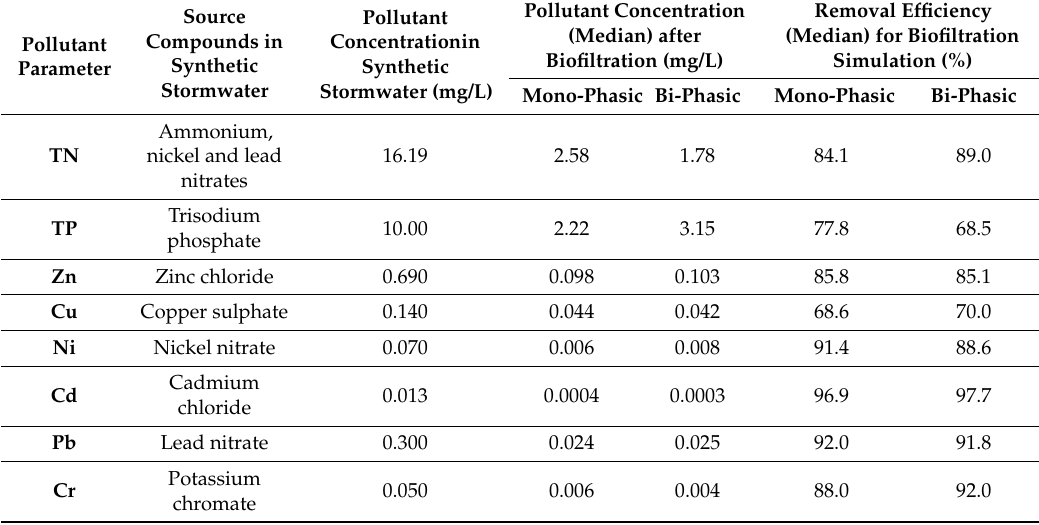
Table 2. Pollutant concentrations and removal efficiency by monophasic and biphasic